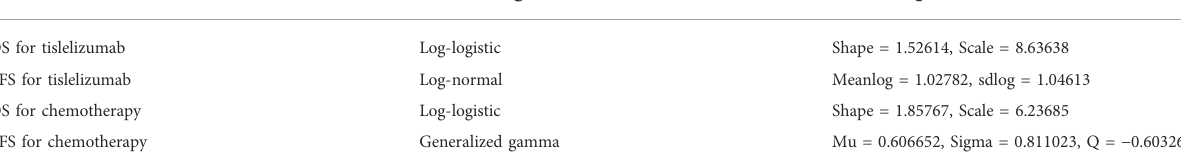
TABLE 1 Survival